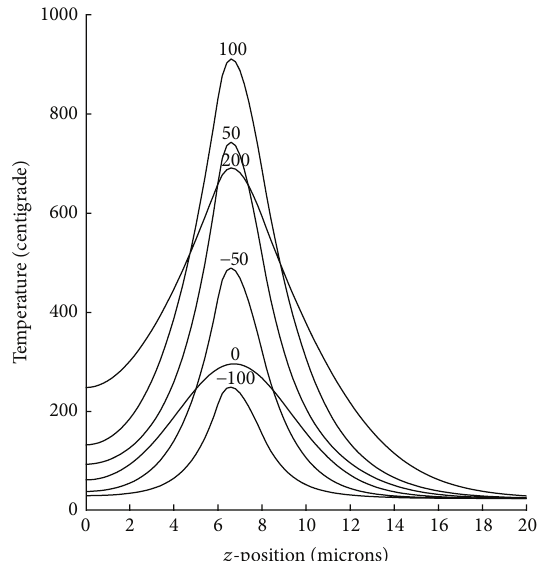
Figure 4: Temperature profiles on 𝑟 = 0 at times 𝑡 = 25, 50, 75 , and 100 𝜇 sforanuniformlydistributedabsorberinthedyelayer(heating phase). The laser is stationary.